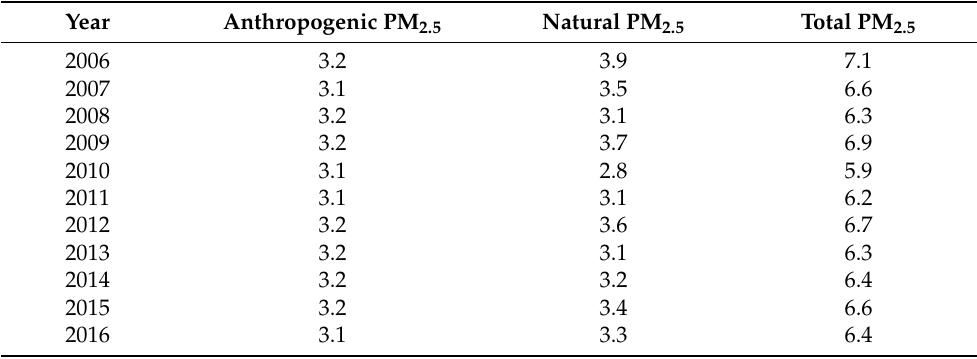
Table 1. Estimated population-weighted national anthropogenic, non-anthropogenic and total PM 2.5 ( µ g/m 3 ) by